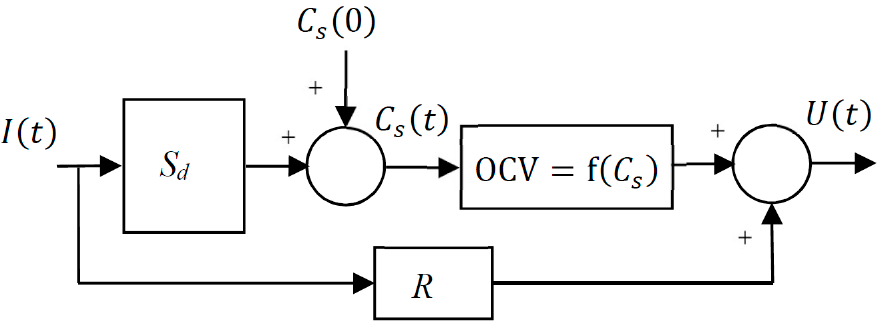
Figure 7. Model of a lithium-ion cell proposed in [25].